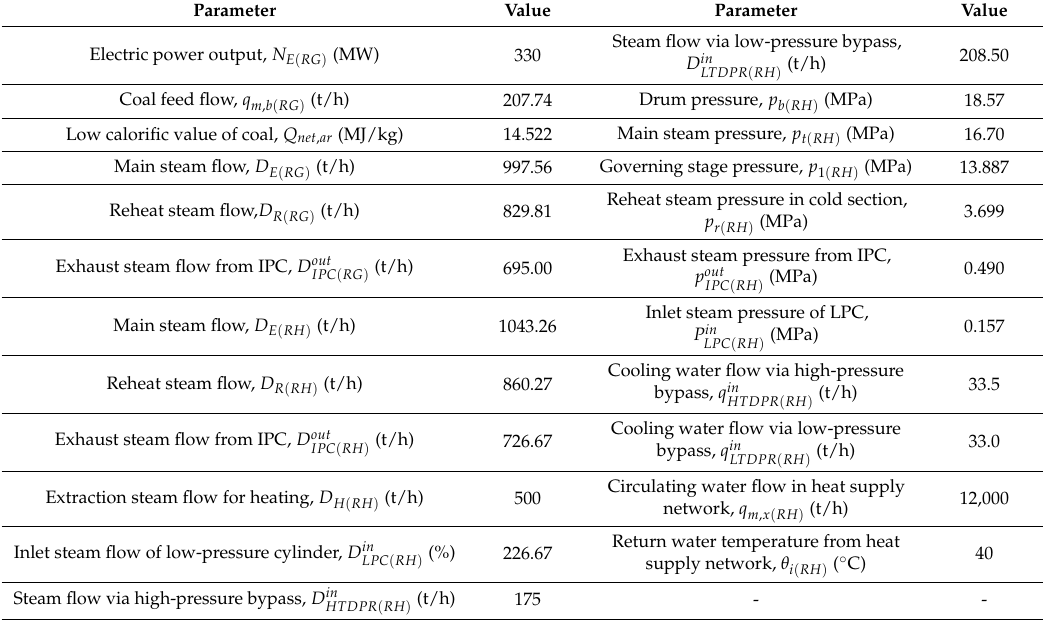
Table 2. Designed data of a CHP unit in